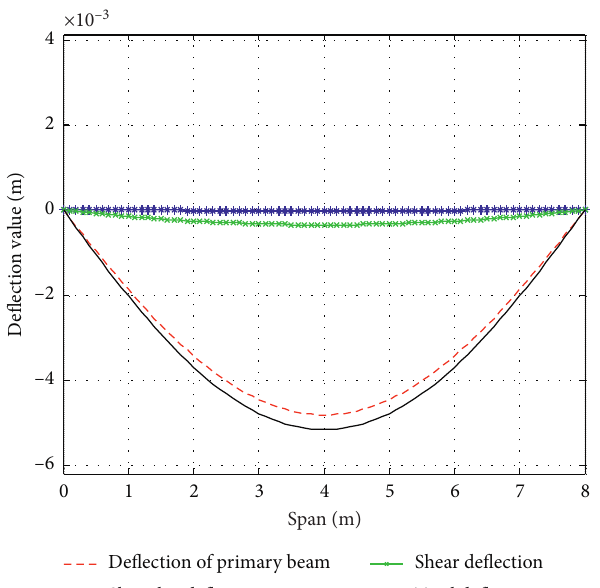
Figure 13: Uniform load-deflection diagram of the single box and single room simply supported composite box girder.